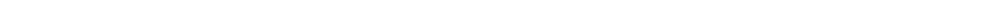
figure on next Fig. 1 Mononuclear cell infiltrates induced by ConA are decreased in Par2KO compared to WT mice. One day after injection, WT mice treated with ConA (10mg/kg) had areas of hemorrhage and mononuclear cell infiltrates (compare B , G to untreated mice in A , F ). These infiltrates were less severe in the Par2KO (compare D , I to B , G ), although specifically, hepatocellular necrosis is more apparent in Par2KO ( D ). In the WT, mononuclear cell infiltrates were more evident at day 14 ( C , H ), while in the Par2KO, there were no infiltrates ( D , E , I , J ). Scale bar mononuclear cell infiltrate in Par2-positive and negative areas. L Quantification of the hepatocellular damage (the percentage area of necrotic lesions) presented in A – J ( n 4 for each condition). Note that hepatocellular damage is observed both in WT and Par2KO regardless of leukocyte = infiltration. Black—statistical significance within the same group. Red—statistical significance in comparison to untreated WT. Blue—statistical significance between WT and KO at day 1. Statistical significance was measured using T test. *Indicates p <0.05, ** p <0.01, *** p <0.005, error bars